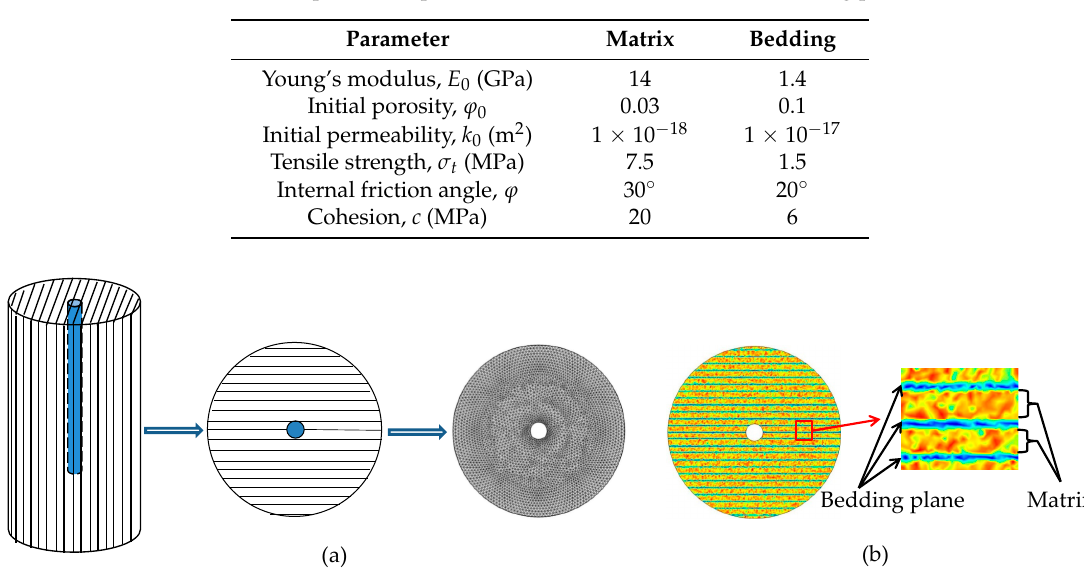
Table 1. Computational parameters of the shale matrix and bedding plane.